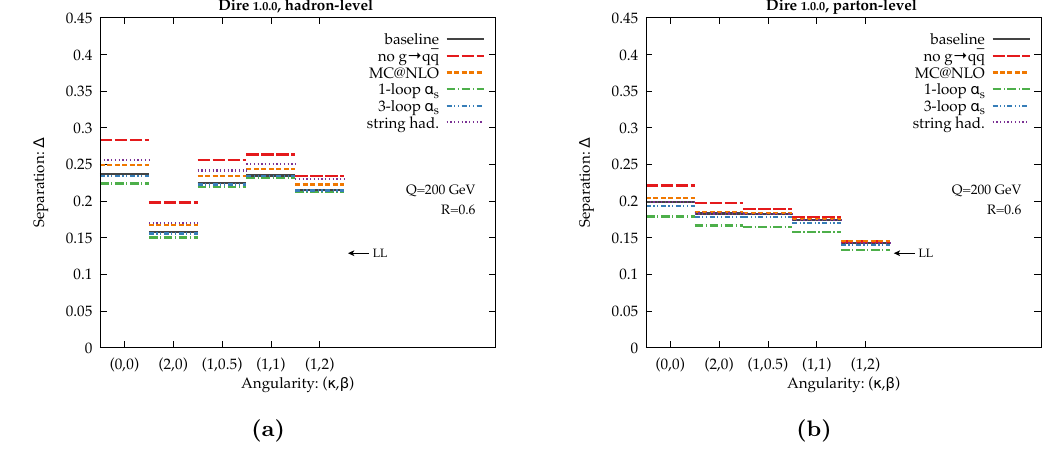
Figure 14. Same as (cid:12)gure 9, but for Dire 1.0.0